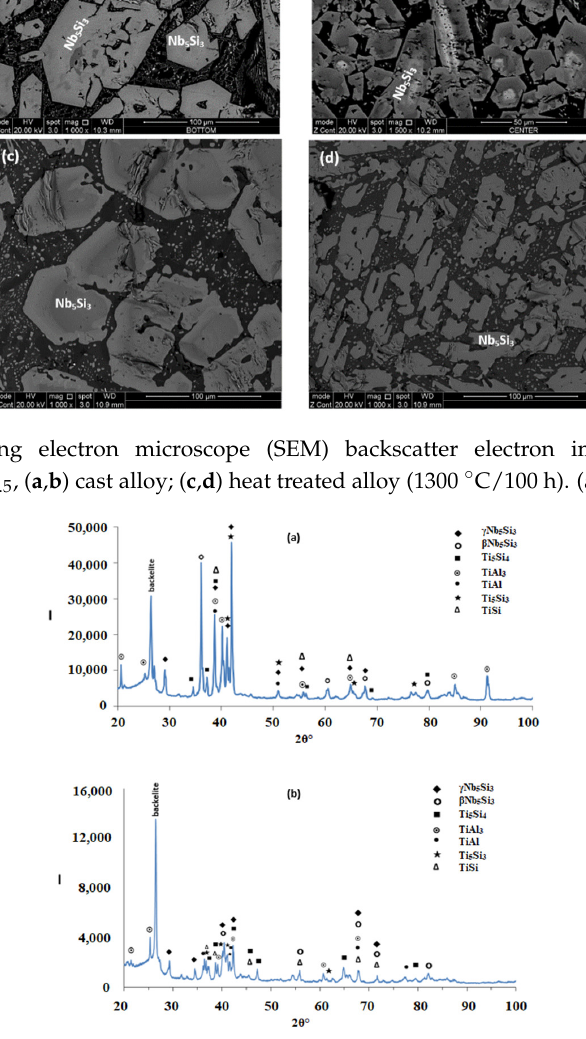
Figure 2. X-ray diffractograms of the alloy Nb 1.7 Si 2.4 Ti 2.4 Al 3 Hf 0.5 , ( a ) as cast; ( b ) heat treated (1300 °C/100 h). Zones of different microstructure were not observed in the cross sections of the cast alloy even though there were differences in composition between bottom, bulk and top of the button, see Figure 3a. The bulk was poorer in Al compared with the bottom and top, the bottom was richer in Ti than the bulk and top and the top was poorer in Si than the bottom and bulk.